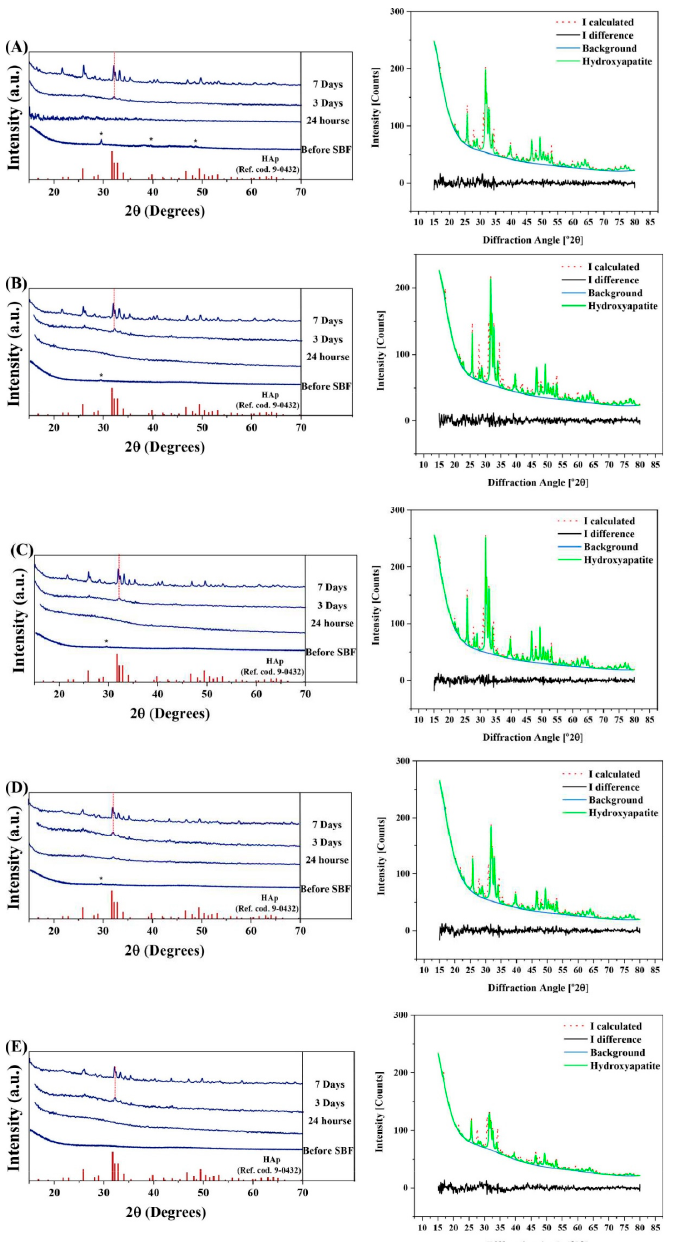
Figure 4. XRD patterns and Rietveld refinement study of the un-doped ( A ), 1 ( B ), 2.5 ( C ), 5 ( D ), and 7.5 ( E ) mol% Ag-doped MBGs. The observed peaks (labeled with *) in the XRD patterns of the samples before soaking in SBF are related to calcium borate (CaB 2 O 4 , ICDD ref. cod. 01-076-0747, orthorhombic).